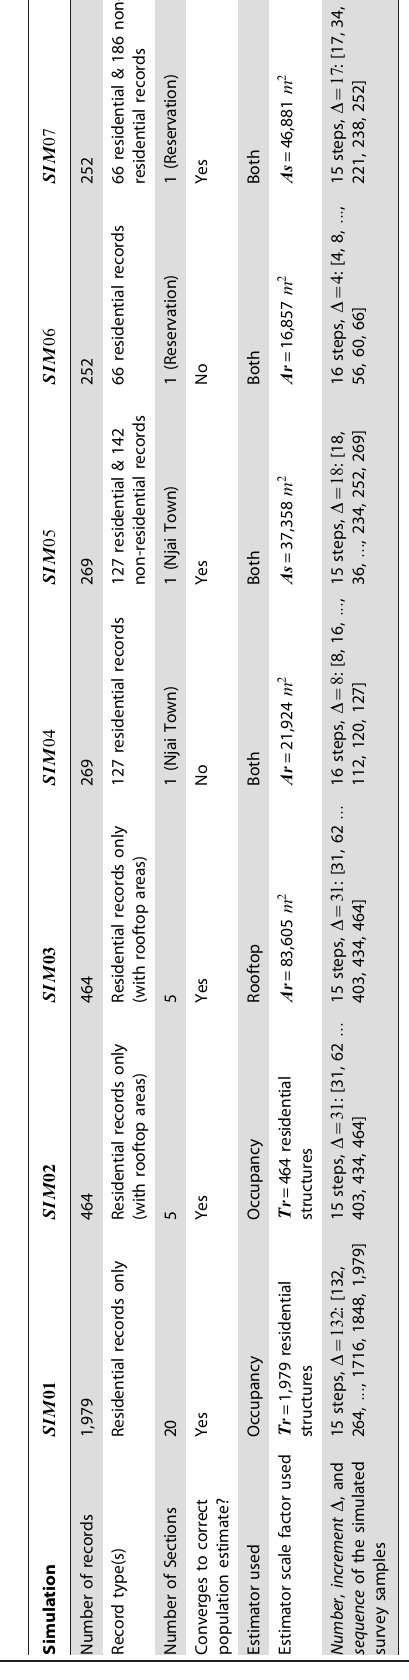
Figure 3 is a flowchart of the bootstrap simulation approach used. Two estimators are tested, the occupancy-based population estimator and the rooftop area-based population estimator. For a given dataset, and for each sample size n , 2,000 replicate bootstrap samples are created (step 2), using the population bootstrap algorithm. The desired population estimate is calculated for each replicate (step 3), along with the associated confidence